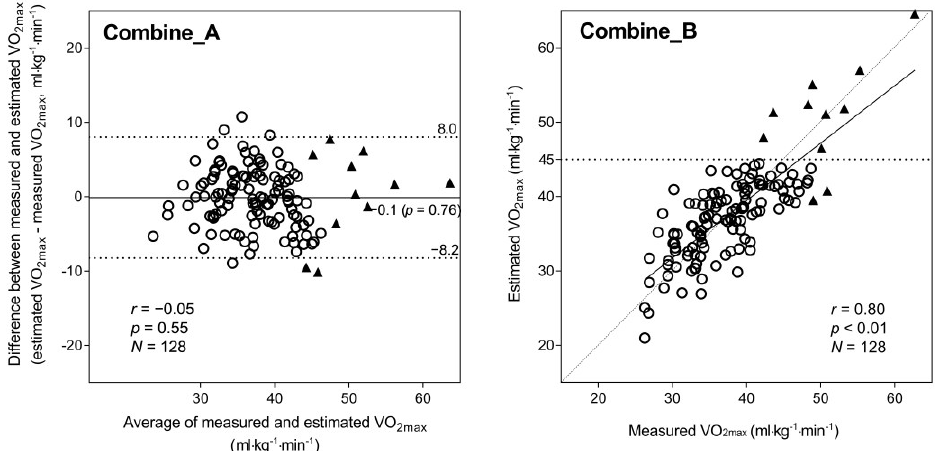
Figure 3. Bland–Altman plot ( A ) and correlation chart ( B ) with mVO 2max and eVO 2max using the combined method. In the Bland–Altman plots ( A ), the mean difference is shown as a solid line, and the 95% LoA is indicated as dashed lines; the regression line and correlation coefficient are also shown. In the correlation chart ( B ), the regression line and correlation coefficient are shown; the dashed line is the ideal line for the estimated and measured values. A total of 11 participants whose eVO 2max with the MRM exceeded 45.0 mL · kg − 1 · min − 1 are shown with a black triangle in ( A , B ). Abbreviations: eVO 2max , estimated VO 2max ; LoA, limit of agreement; MRM, multiple regression model; mVO 2max , measured VO 2max ; and VO 2max , maximal oxygen consumption.